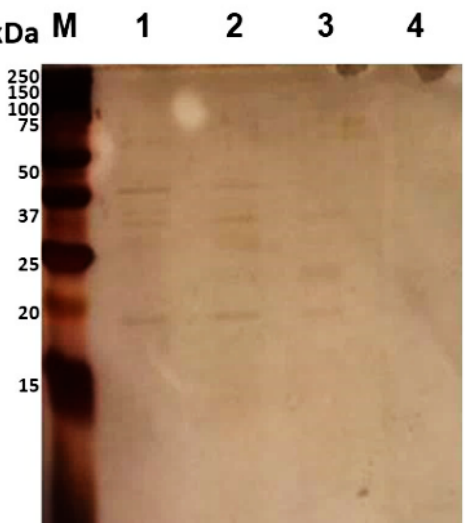
Figure 2. Separation of trypsin-digested mixtures of B. cenocepacia J2315 by 15% SDS-PAGE, followed